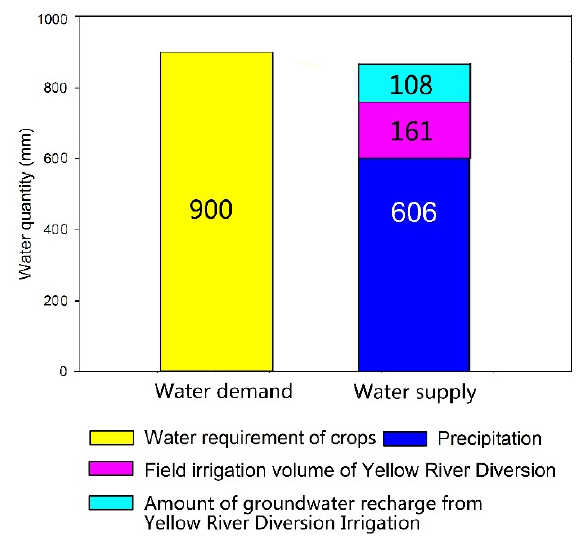
Figure 4. Water balance of the Yellow River Irrigation District at 50% probability of precipitation.